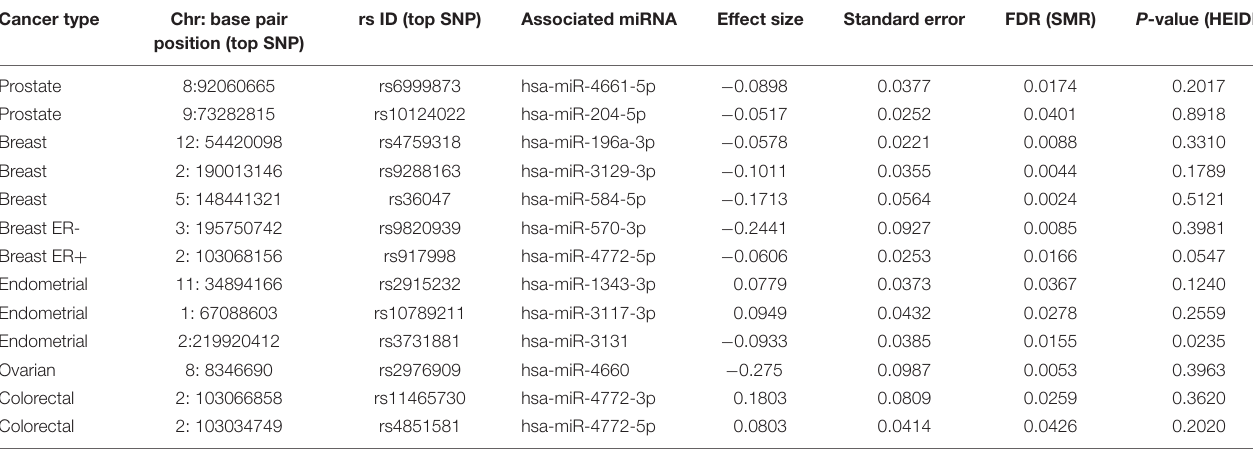
TABLE 1 | Summary data-based Mendelian randomization (SMR)–heterogeneity in dependent instruments (HEIDI) test results for significant microRNAs (miRNAs) in hormone-dependent cancers (HDC). Cancer